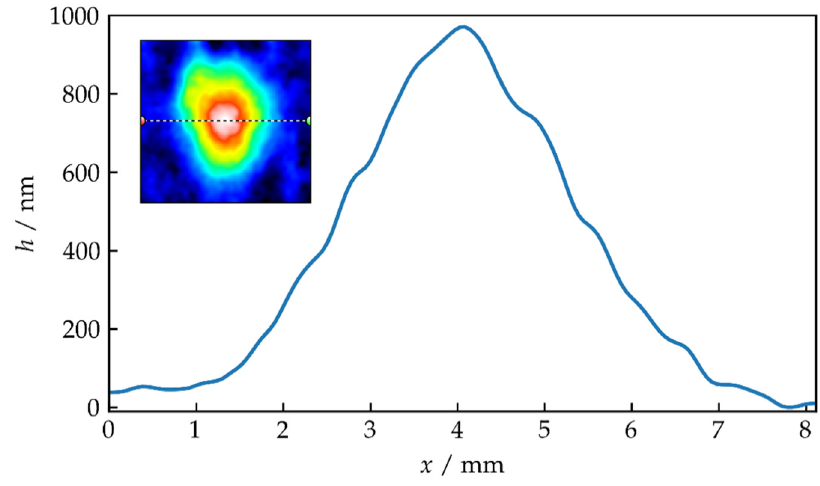
Figure 3. Extracted 2D film profile of the STF35 film formed by DPAD. The dashed arrow within the insets depicts the extracted line.